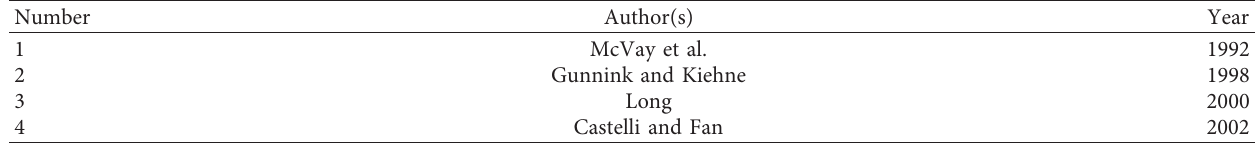
Table 6: Authors and years for references in the present study [17–20].